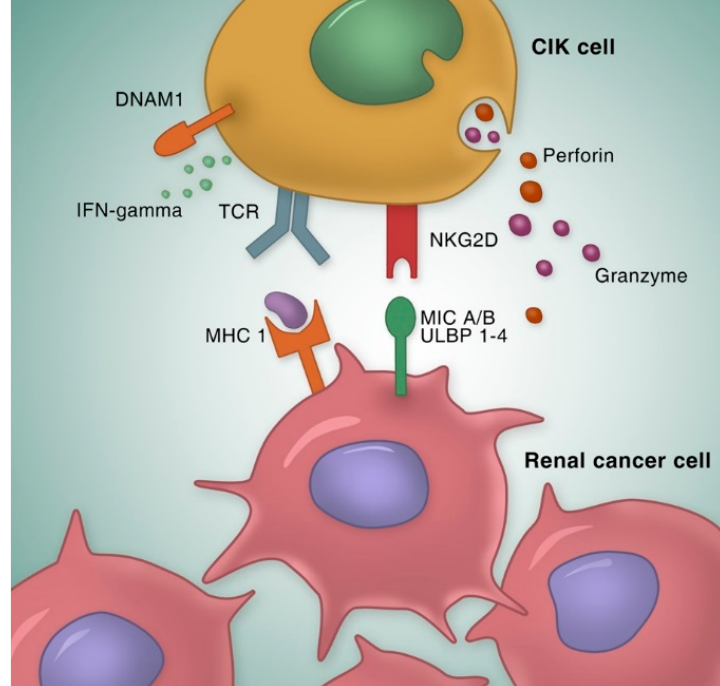
Figure 1. Mechanisms of CIK cell anti-tumor activity. The majority of CIK cell cytotoxicity is exerted through the interaction between NKG2D and its ligand MIC A / B and ULPB 1–4, resulting in granule exocytosis and secretion of cytokines like IFN- γ . NK-like structures, such as DNAM-1, is also involved in the recognition and killing of tumor targets. Besides, CIK cells can eradicate tumors in an MHC-restricted manner by TCR engagement, which is the so-called “dual-functional capability”. CIK cell, cytokine induced killer cells; NKG2D, natural killer group 2 member D; MIC A / B, MHC class I polypeptide-related sequence A / B; ULPB 1–4, UL16 binding protein 1–4. DNAM-1, DNAX accessory molecule-1; TCR, T-cell receptor; MHC 1, major histocompatibility complex 1; IFN- γ , interferon- γ